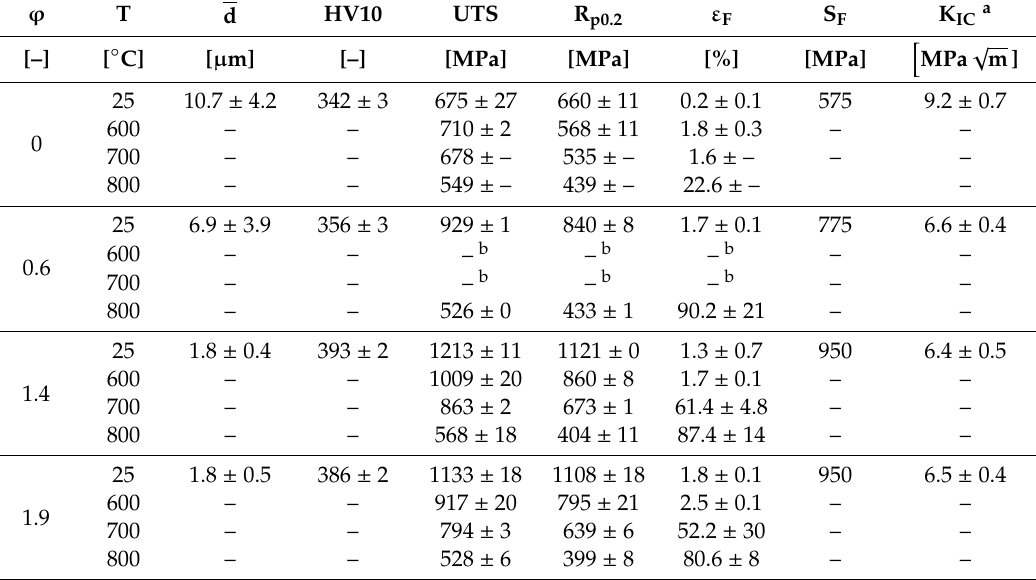
Table 1. Summary of the mechanical properties obtained for the TNM alloy at room temperature (RT), 600 ◦ C, 700 ◦ C, and 800 ◦ C with varying ϕ , including the standard deviation of the respective data point. UTS: ultimate tensile